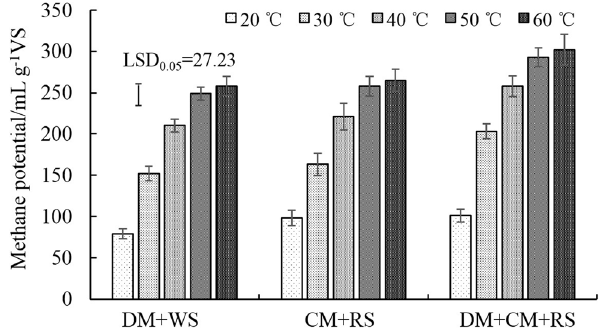
Figure 1. Effects of temperature on methane potential in mixtures with a C/N ratio of 25. Values are presented as the mean 6 standard error of three replicates (n=3). Vertical bars represent LSD at the 5%